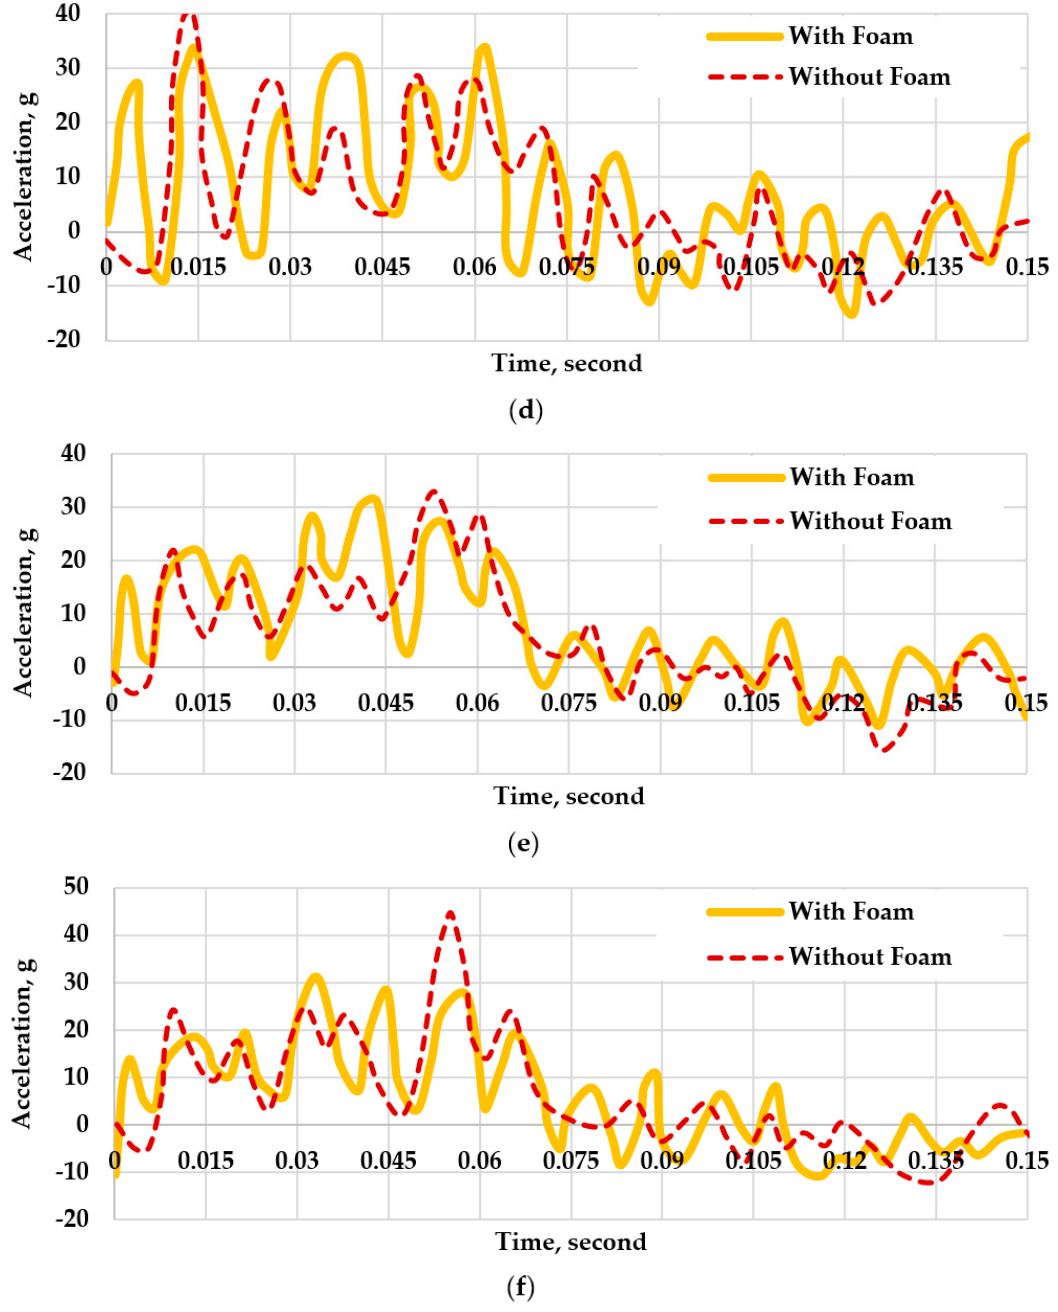
Figure 8. Acceleration responses on the cabin floor: ( a ) Node I; ( b ) Node II; ( c ) Node III; ( d ) Node IV; ( e ) Node V; ( f ) Node VI.